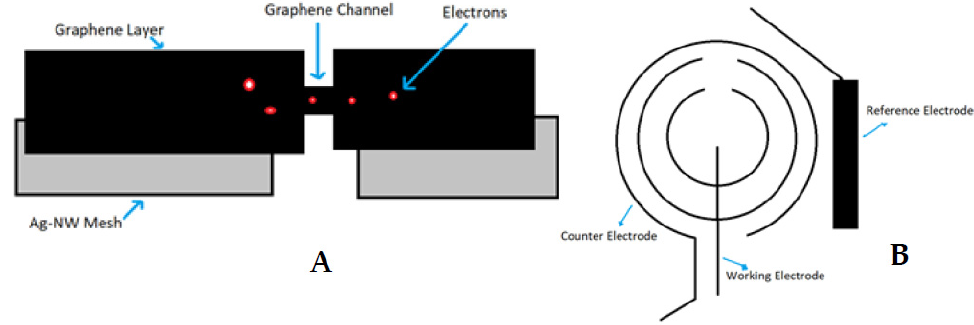
Figure 1. Glucose-sensing principles for contact lenses; graphene hybrid glucose sensor ( A ) and amperometric glucose sensor ( B amperometric glucose sensor ( B ).